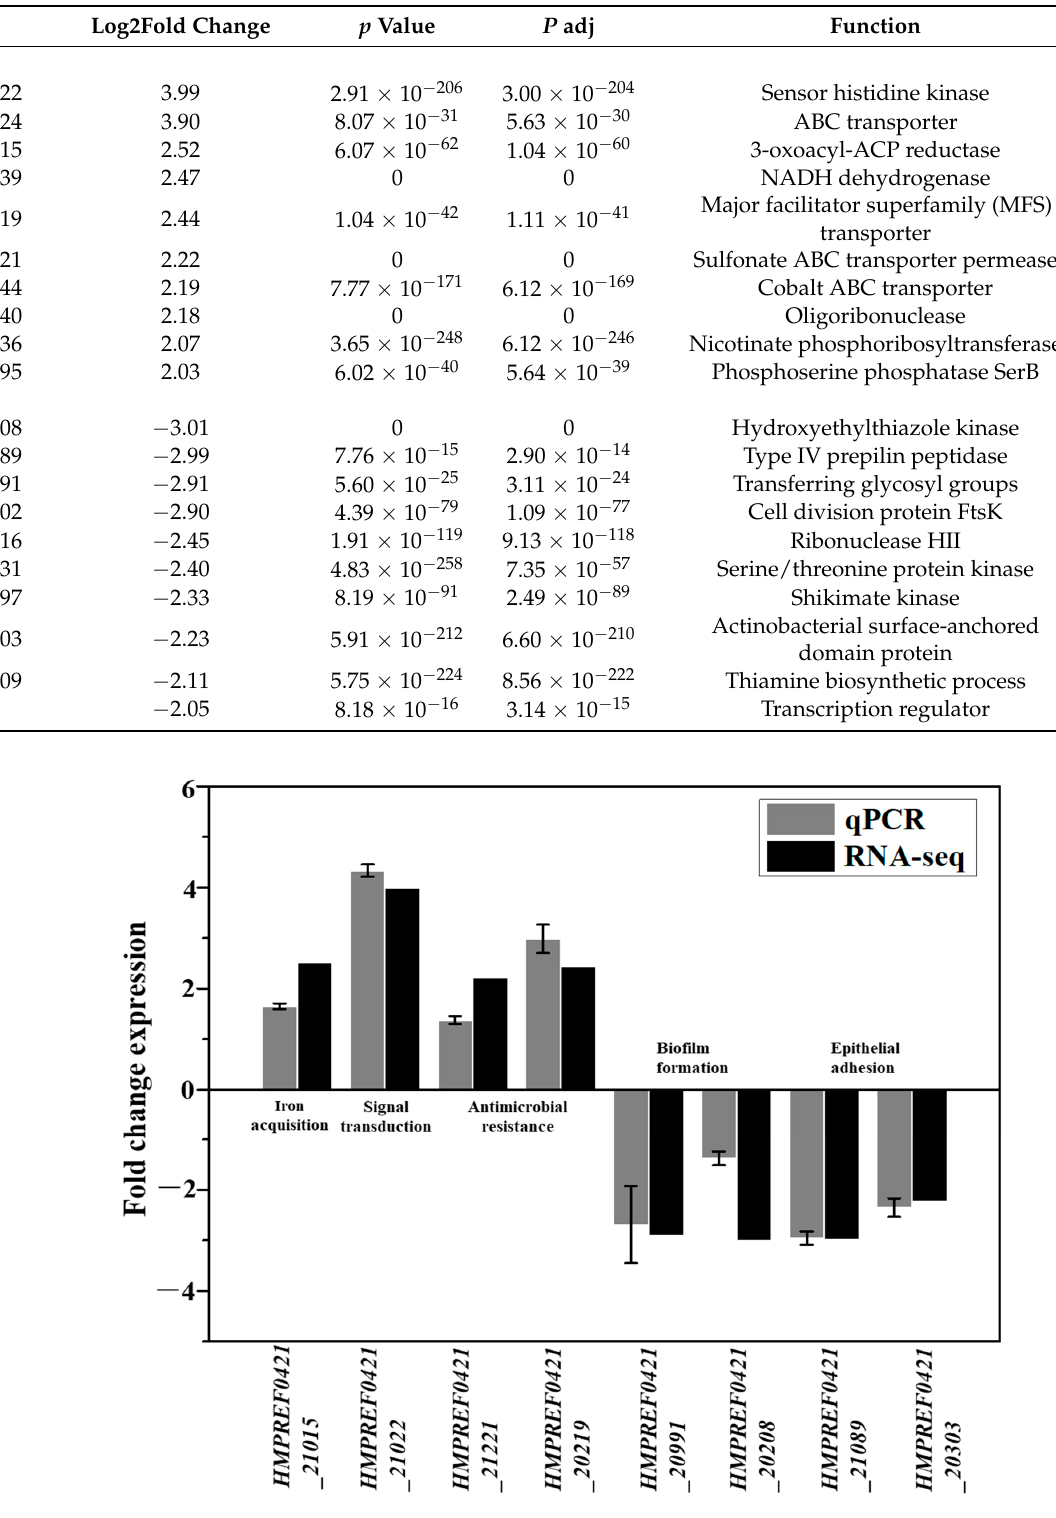
Figure 2. Quantification of the transcription of the virulence genes that were expressed differentially in G. vaginalis cultured under lactate and hydrogen peroxide. Bars represent the mean, and the error bars the standard error of the mean (mean ± SEM). Table 1. List of the 10 genes with the highest fold change values among the differentially expressed genes in G. vaginalis cultured under lactate and hydrogen peroxide. All p values were less than 0.02. P adj